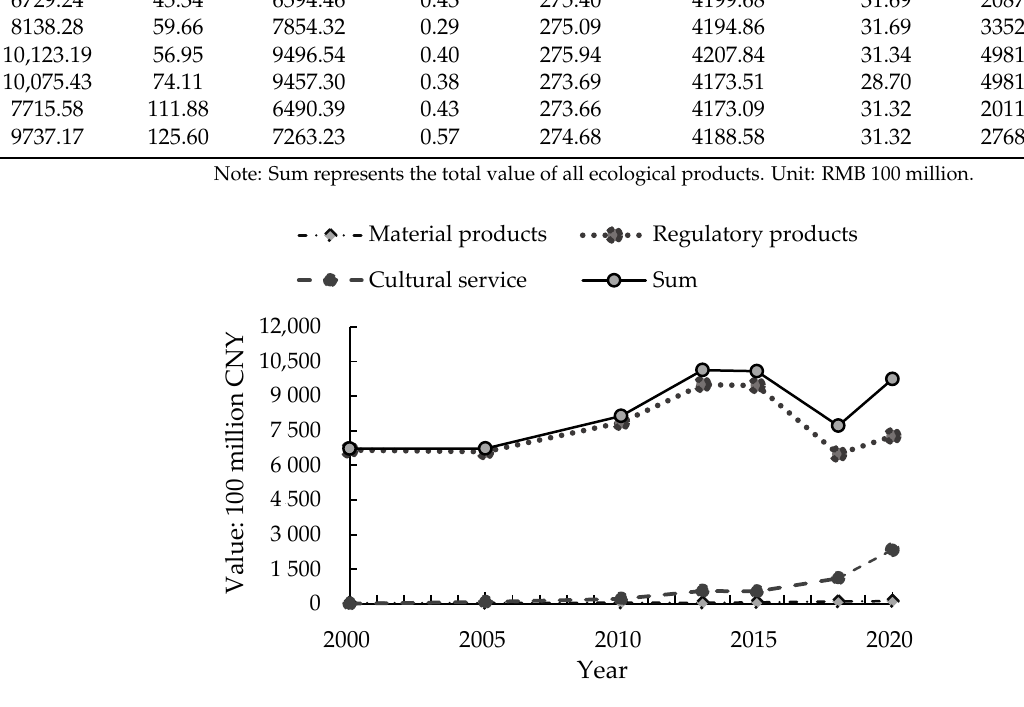
Figure 3. The changing trend of the value of various ecological products in Zhejiang Province from 2000 to